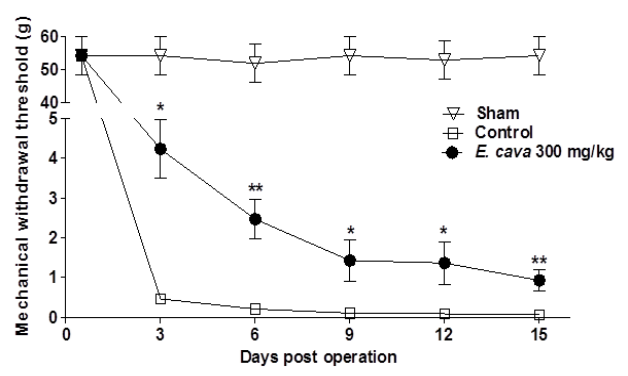
Figure 4. Effect of E. cava extracts on SNI rat model of neuropathic pain. Administration of E. cava extracts (300 mg/kg, p.o) significantly attenuated hypersensitivity in response to von Frey stimulation of hind paw from 3 to 15 day after treatment. Data are mean ± SEM (n = 7 per group). ** p < 0.01, and * p < 0.05 significant difference from control